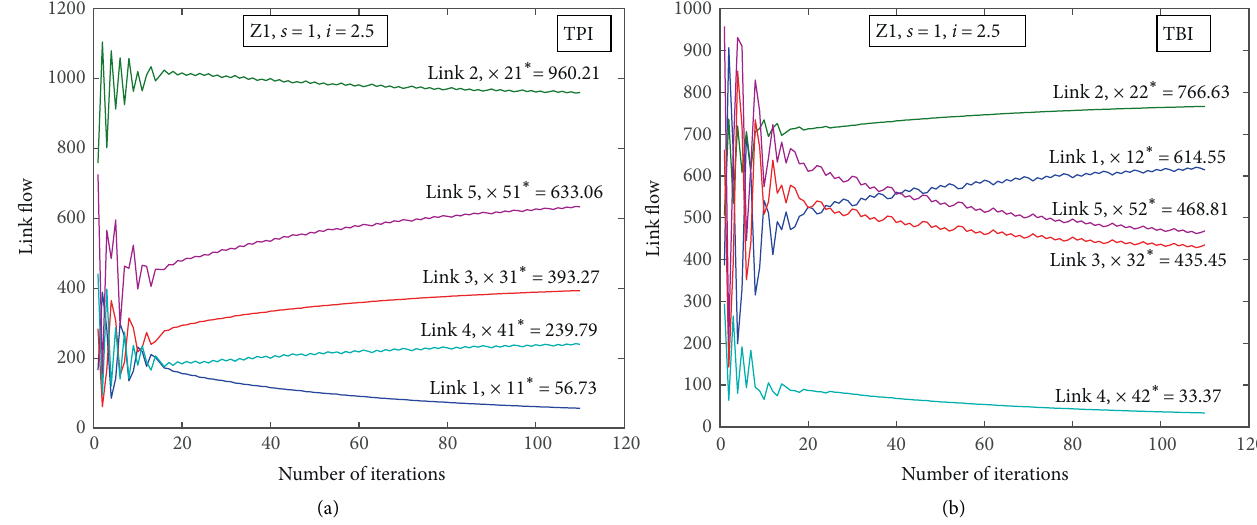
Figure 4: Convergence curves of link flows of TPI or TBI (Z1, curves of link flows of TBI (Z1, s = 1).